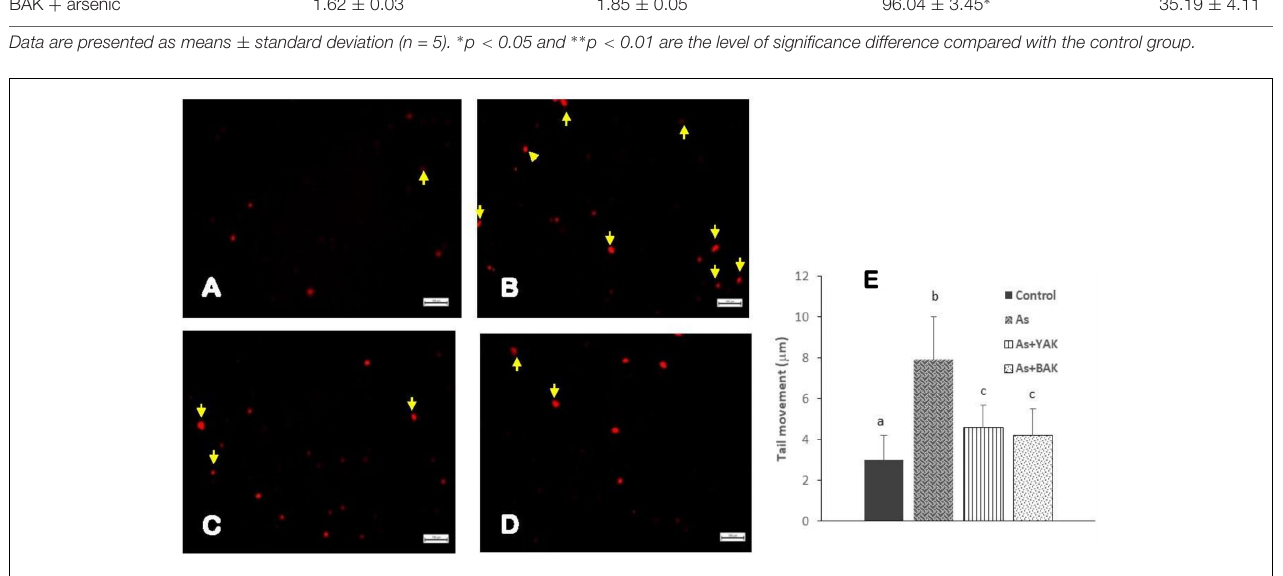
FIGURE 4 | | Determination of the genotoxic protective effects of khambir extracts against arsenic toxicity by Comet assay. Fluorescent microscopic image of (A) control tissue, (B) arsenic treated, (C) co-supplementation of arsenic and YAK, and (D) co-supplementation of arsenic and BAK; (E) graphical representation of the comet tail length of different experiments. The comet tail length was calculated as the distance between the end of nuclei heads and end of each tail. Values are expressed as the mean ± SD ( n = 100); different superscripts (alphabet) on the bar indicate the different levels of significance ( p < 0.05) among respective